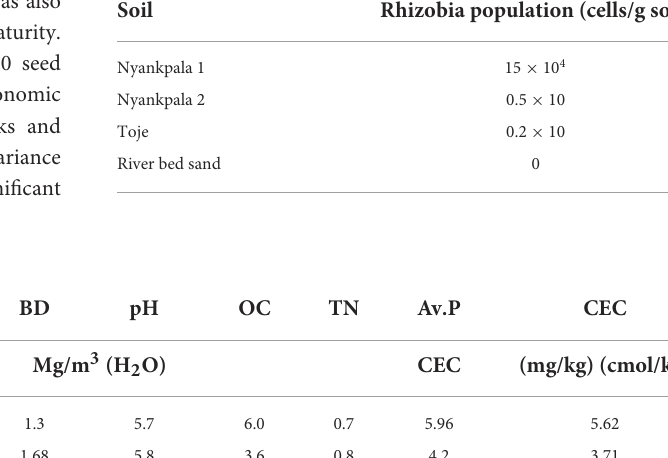
TABLE 2 Population of indigenous rhizobium in the soils.